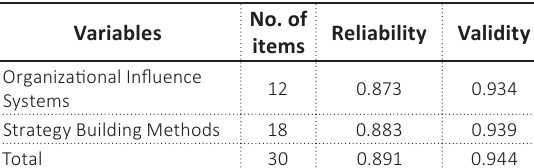
Table 2. Questionnaire validity and reliability